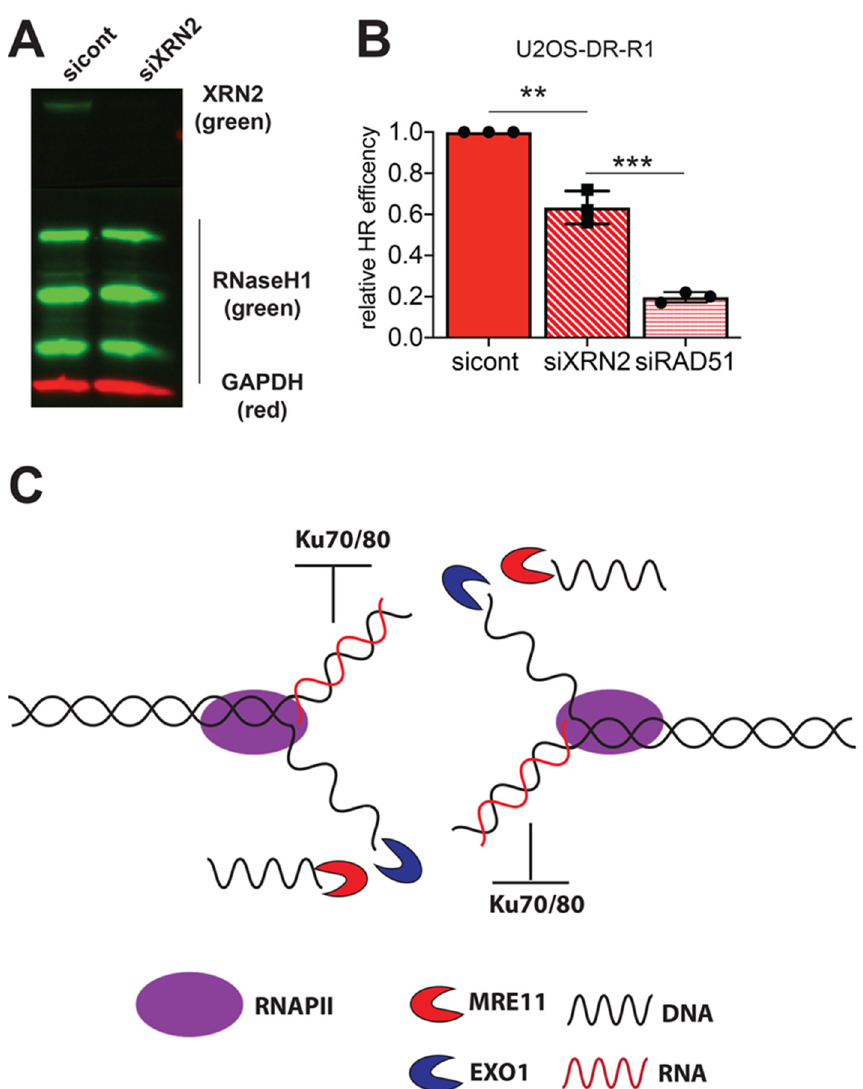
Figure 5. RNaseH1 expression does not rescue HR repair after XRN2 loss. ( A ) Steady-state protein levels of XRN2 was measured in U2OS-DR-R1 cells treated with control and XRN2 siRNAs. ( B ) Efficiency of HR repair in the U2OS-DR-R1 reporter cells exposed to control, XRN2 or Rad51 siRNAs was determined by measuring 1000 cells for GPF expression and normalizing to control cells. ( C ) Model of DSB repair in XRN2 deficient cells. Statistical analysis was done using Student’s t- test. ** = p < 0.01 and **** = p < 0.00001. Detailed information about Western blot can be found at Figure S9.